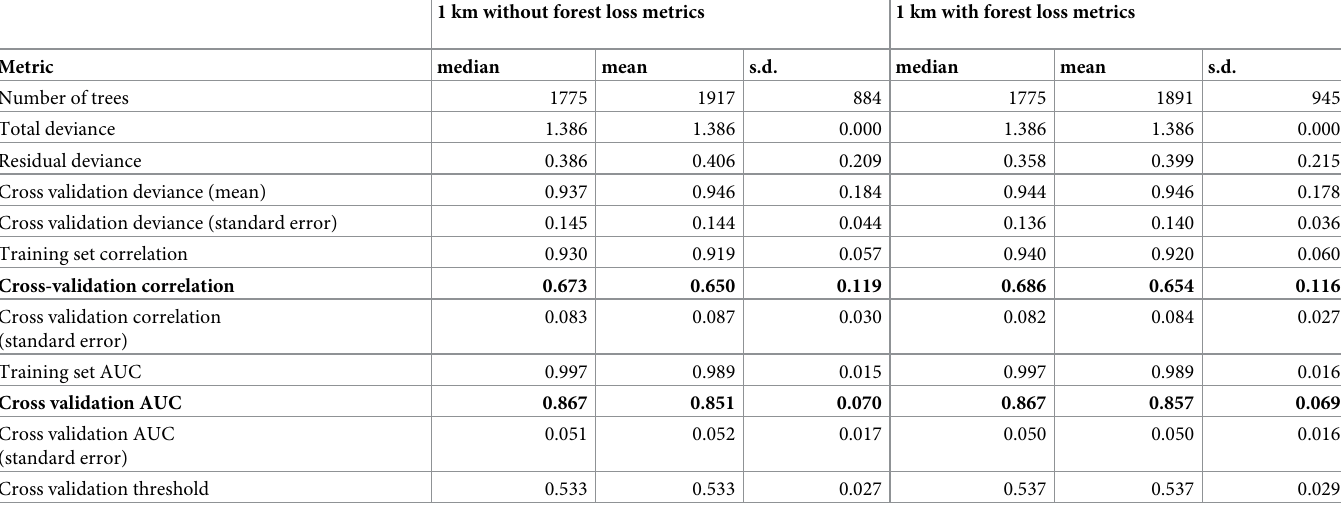
Table 3. Accuracy metrics for BRT models of Kyasanur Forest Disease distribution—1 km resolution.